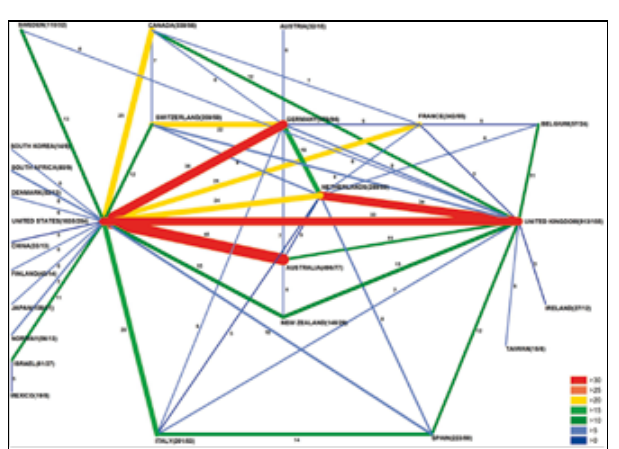
Fig. 6. Comparison of the top five subject areas in which papers on cannabis were published from 1999 to 2008 with those of the previous five decades.